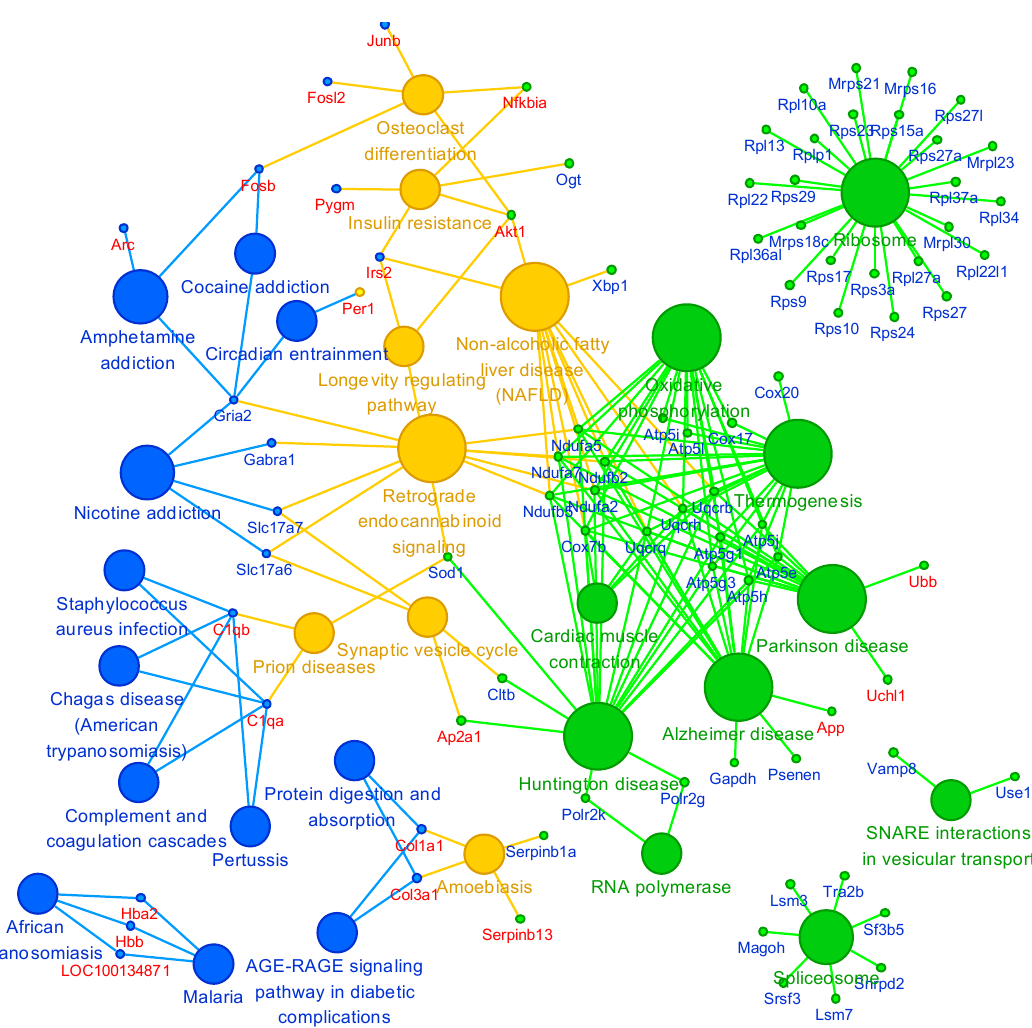
Figure 8. The interaction network between the striatum and the whisker follicle of methamphetamine self-administered rats. Blue color: A striatum-specific pathway (big circles) or genes (small circles), green color: a whisker follicle-specific pathway (big circles) or genes (small circles), and yellow color: the pathways or genes common for the two tissues.